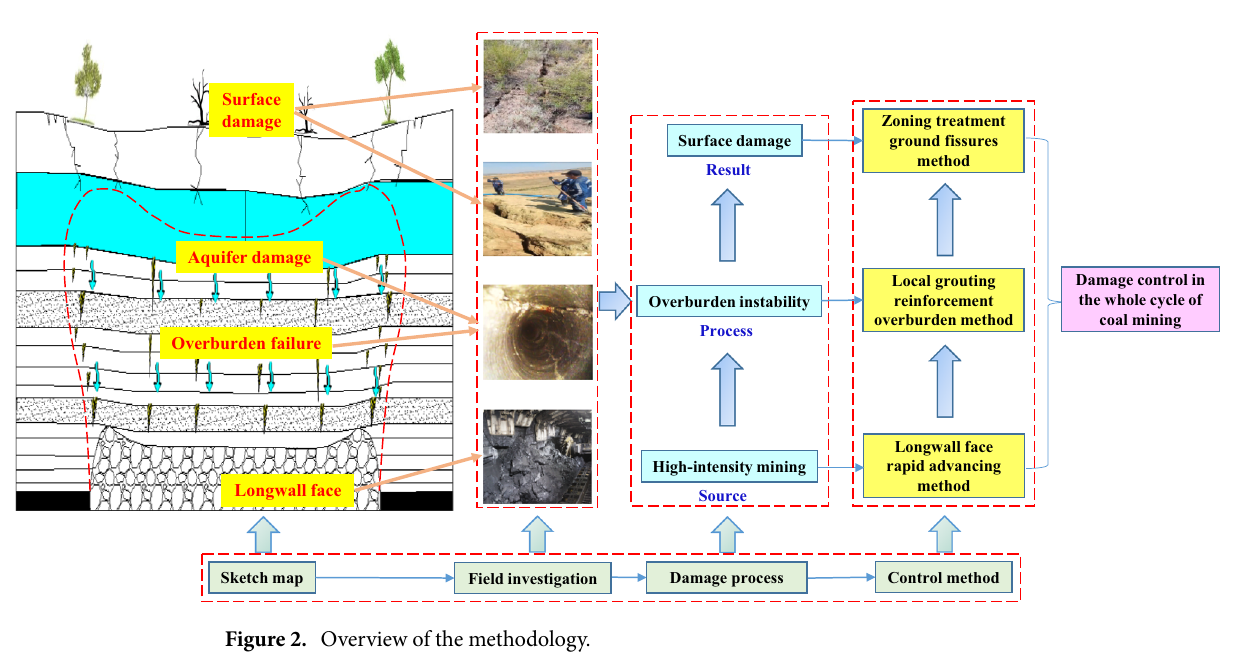
Figure 2. Overview of the